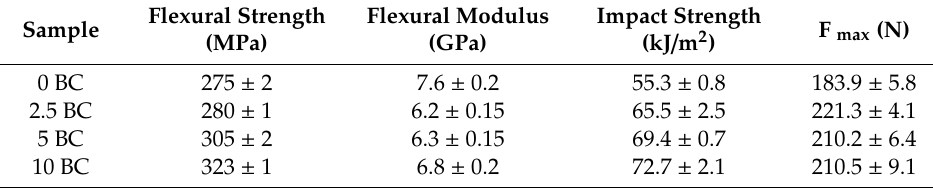
Figure 5. Flexural strength and modulus of the composites. Table 2. Flexural and impact values of the tested materials.